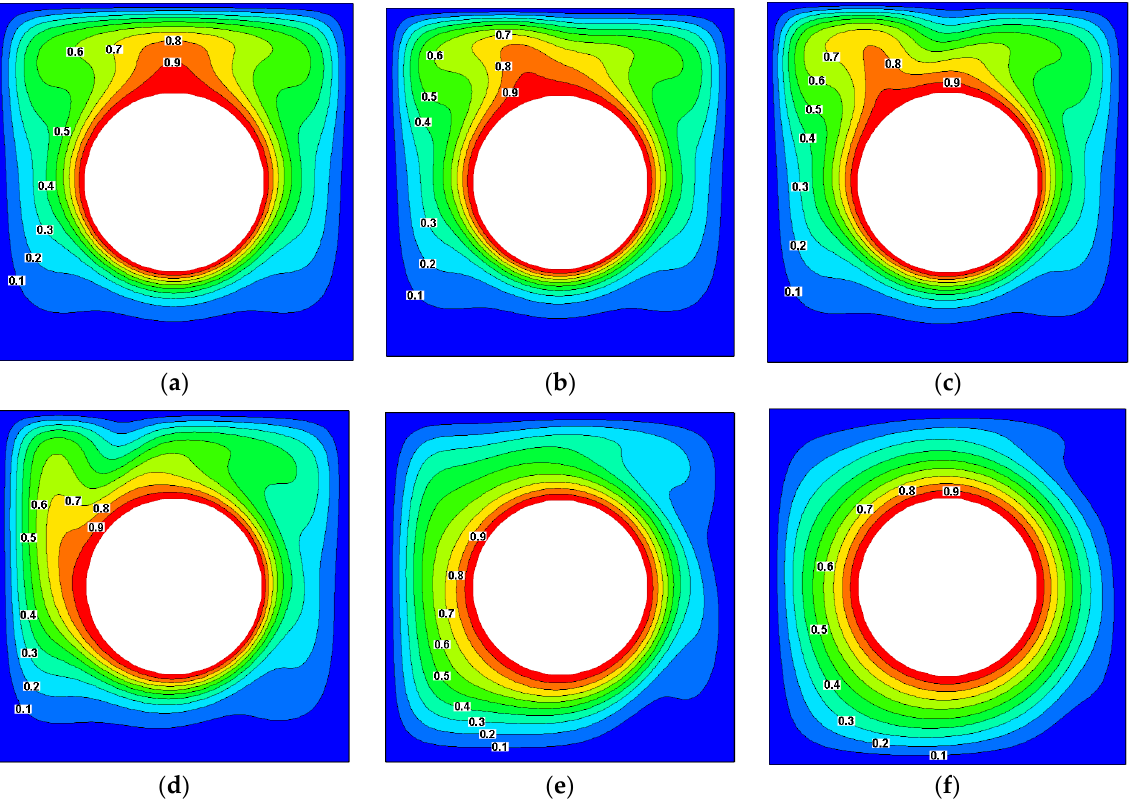
Figure 5. ( a ) N = 0, ( b ) N = 10, ( c ) N = 20, ( d ) N = 50, ( e ) N = 100, ( f ) N = 200. Contours of dimensionless temperature at λ = 0.5, Ha = 0 and Ra = 10 6 .